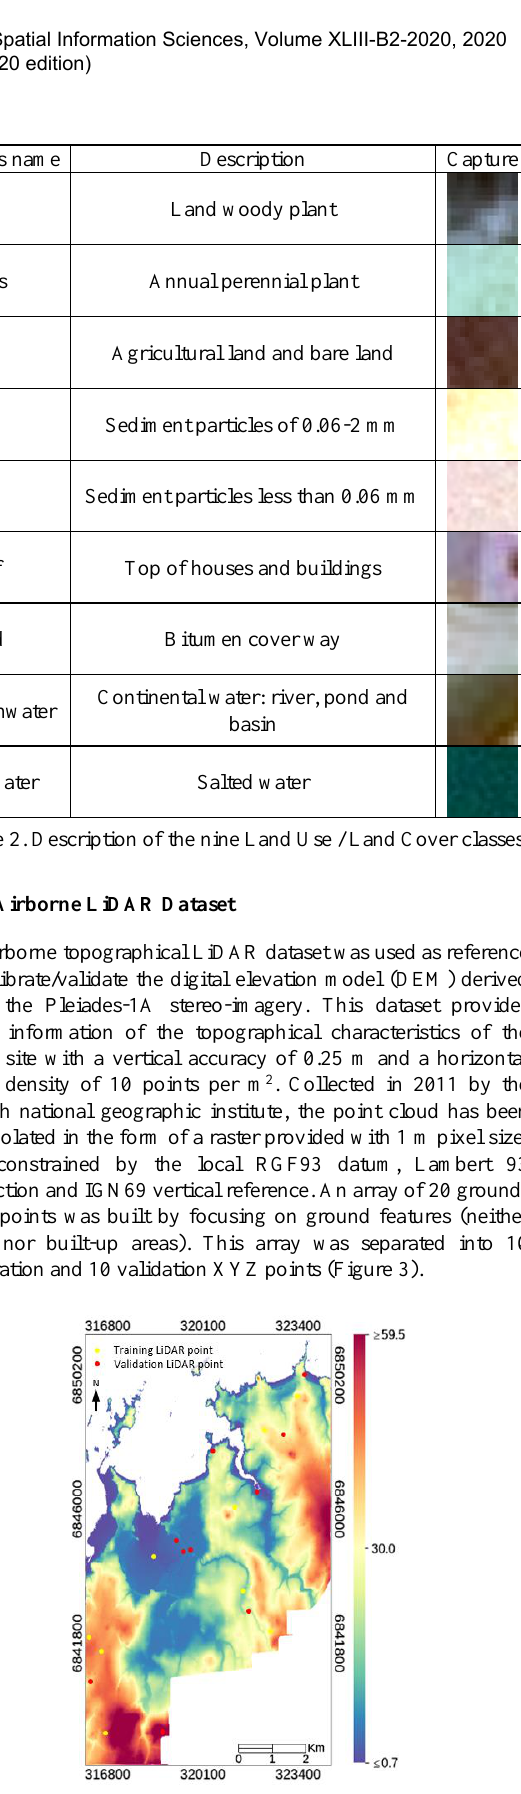
Figure 3. Location of the calibration/validation LiDAR